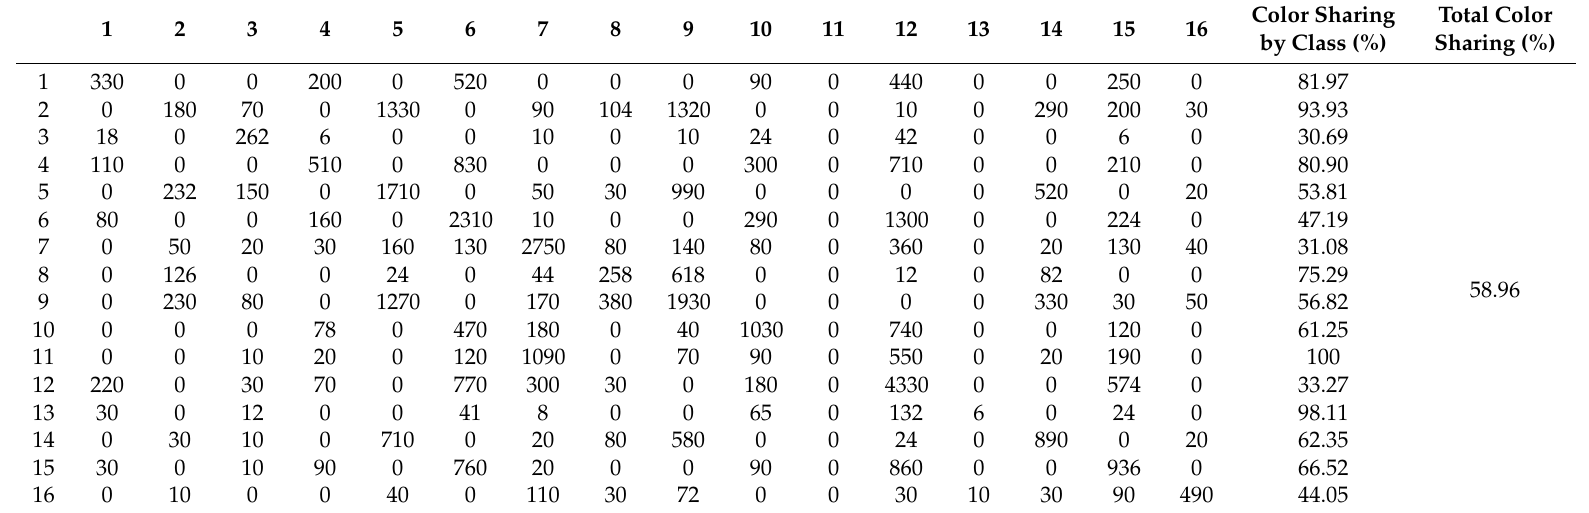
Table 5. Confusion matrix of the classification of 43,914 frames in the 16 classes corresponding to the different lighting conditions, using color features and the hybrid ANN-CA method. Rows: real classes. Columns: predicted classes. The percentage of color sharing of each class is defined as the percentage of frames of that class classified in a different